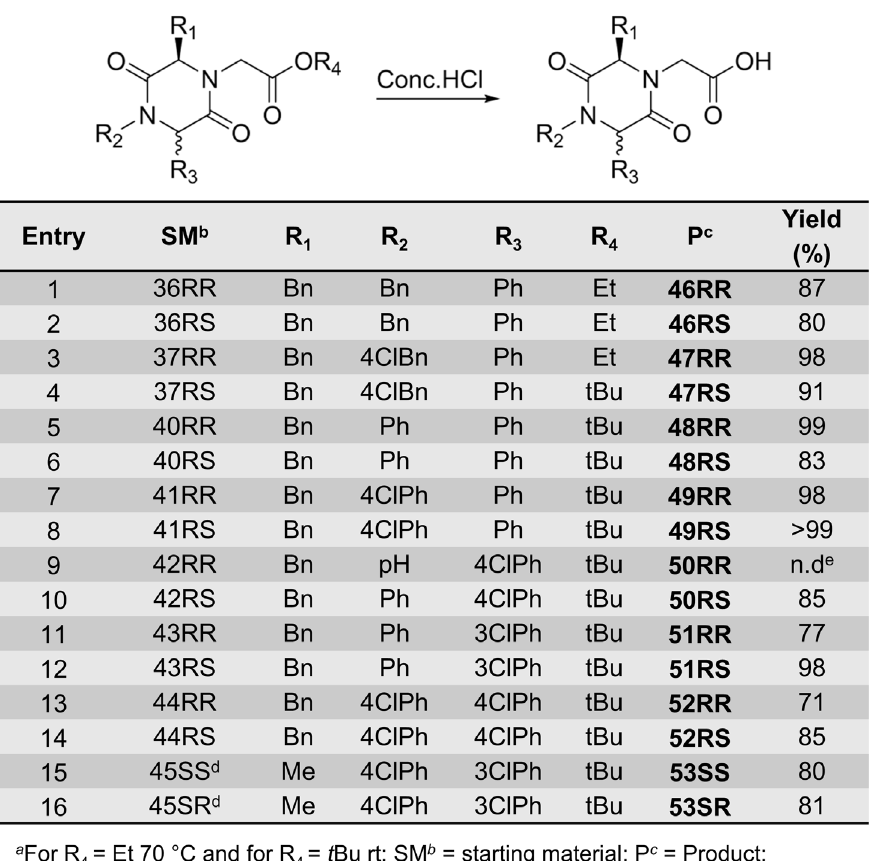
Fig 14. Ester hydrolysis of non-spiro-DKPs afforded acids 46-53. a